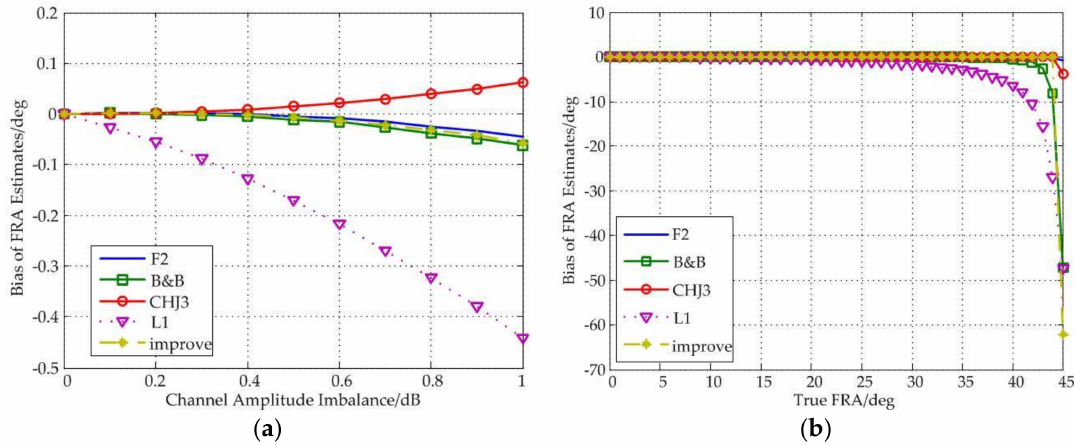
Figure 3. ( a ) Bias of FRA estimates as a function of channel amplitude imbalance under different estimators; ( b ) Bias of FRA estimates as a function of true FRA under different